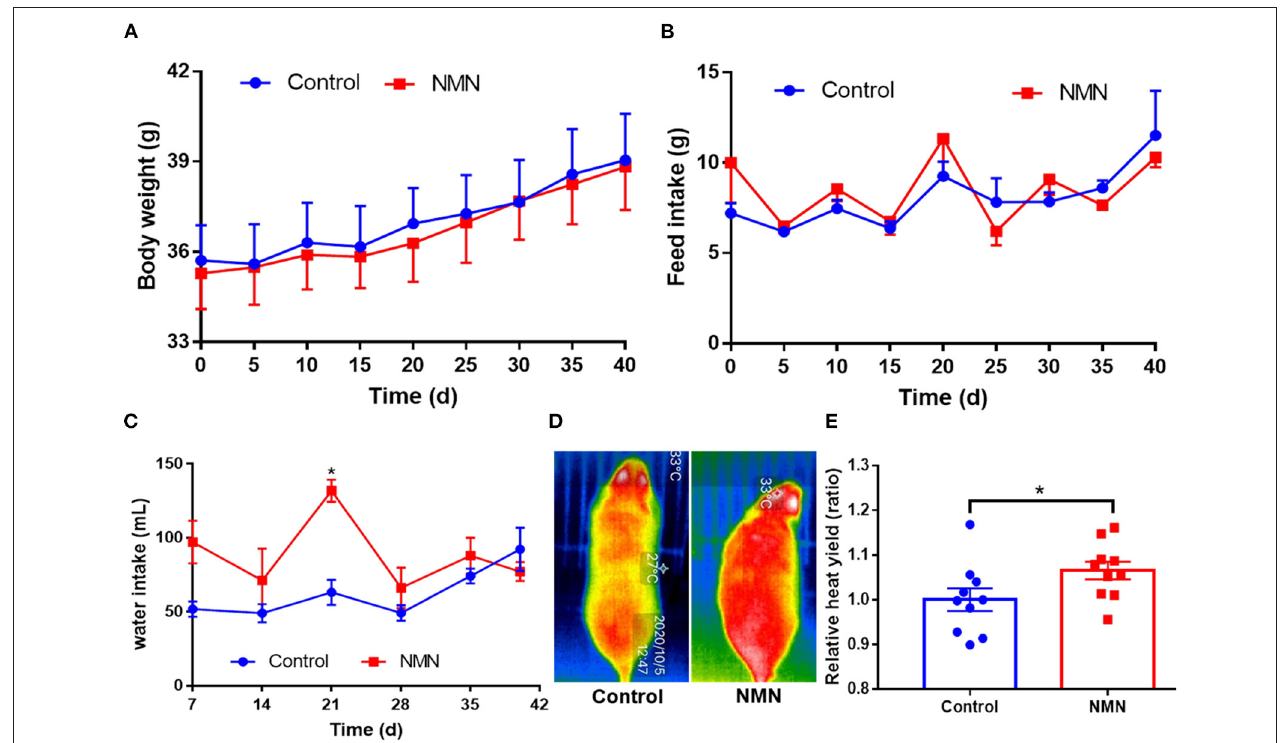
FIGURE 1 | Supplementary effects of nicotinamide mononucleotide (NMN) on the body weight (A) , feed intake (B) , water intake (C) , heat yield image (D) , and histogram (E) of pre-aging mice. Values indicate mean ± SEM ( n = 10). *Indicates significant difference at p < 0.05 level.